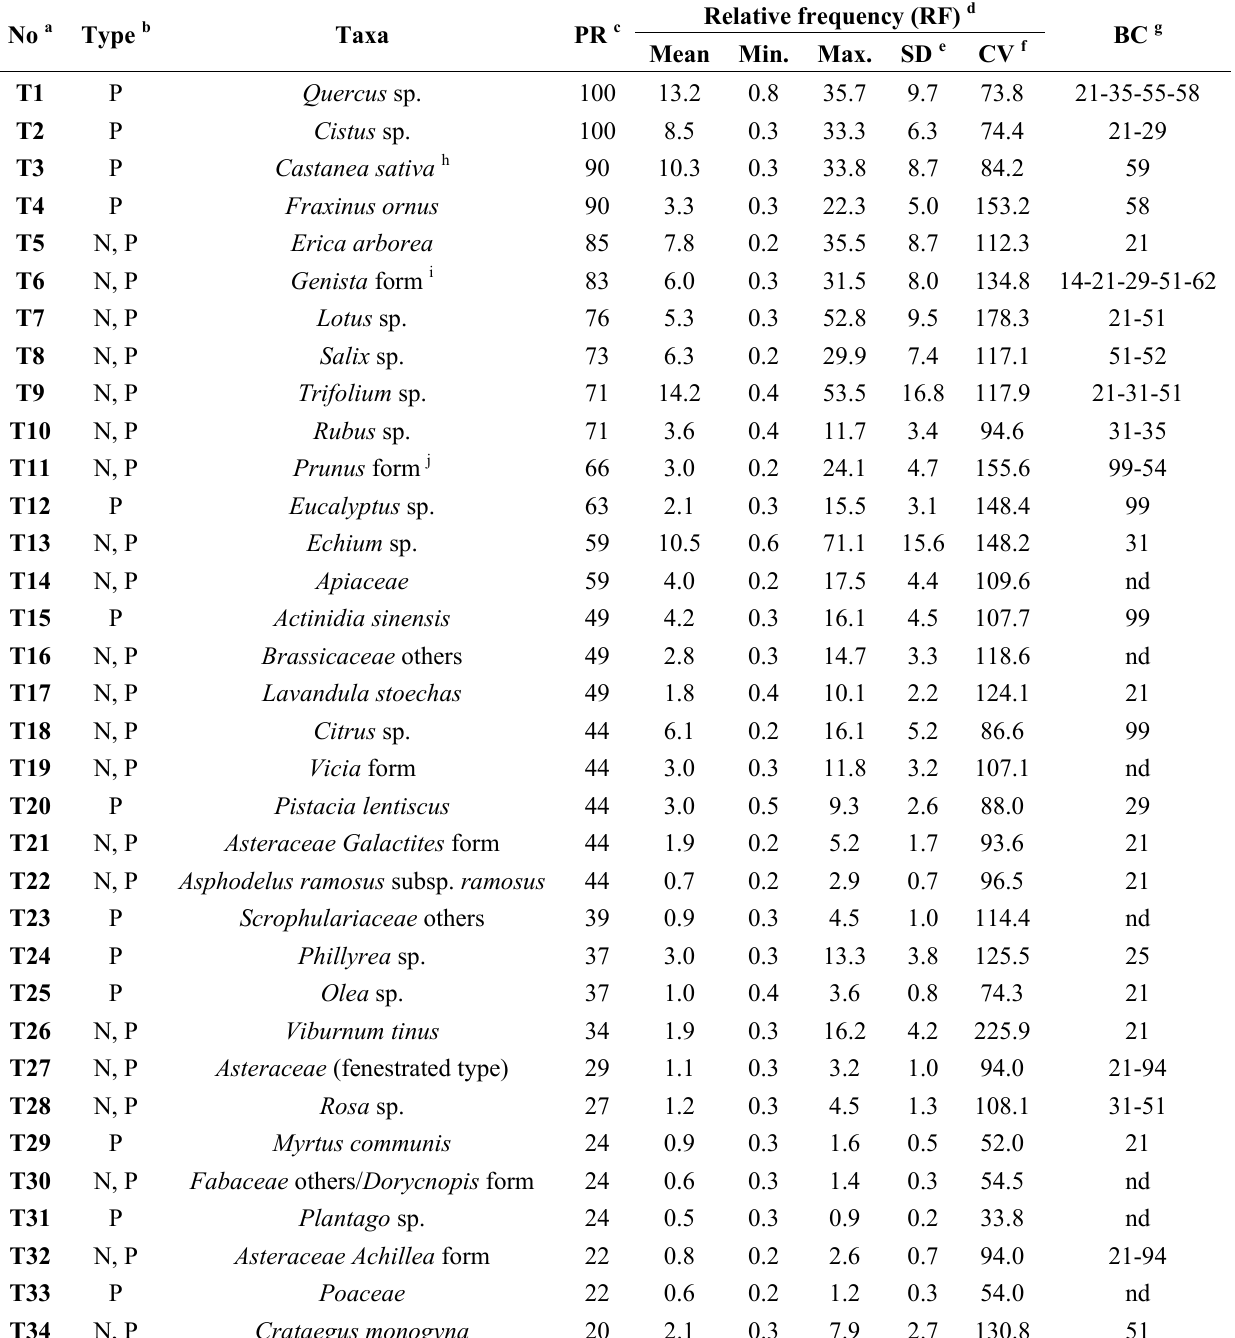
Table 1. Statistical analysis and biogeographical characteristics of Corsican “spring” honeys’ taxa.